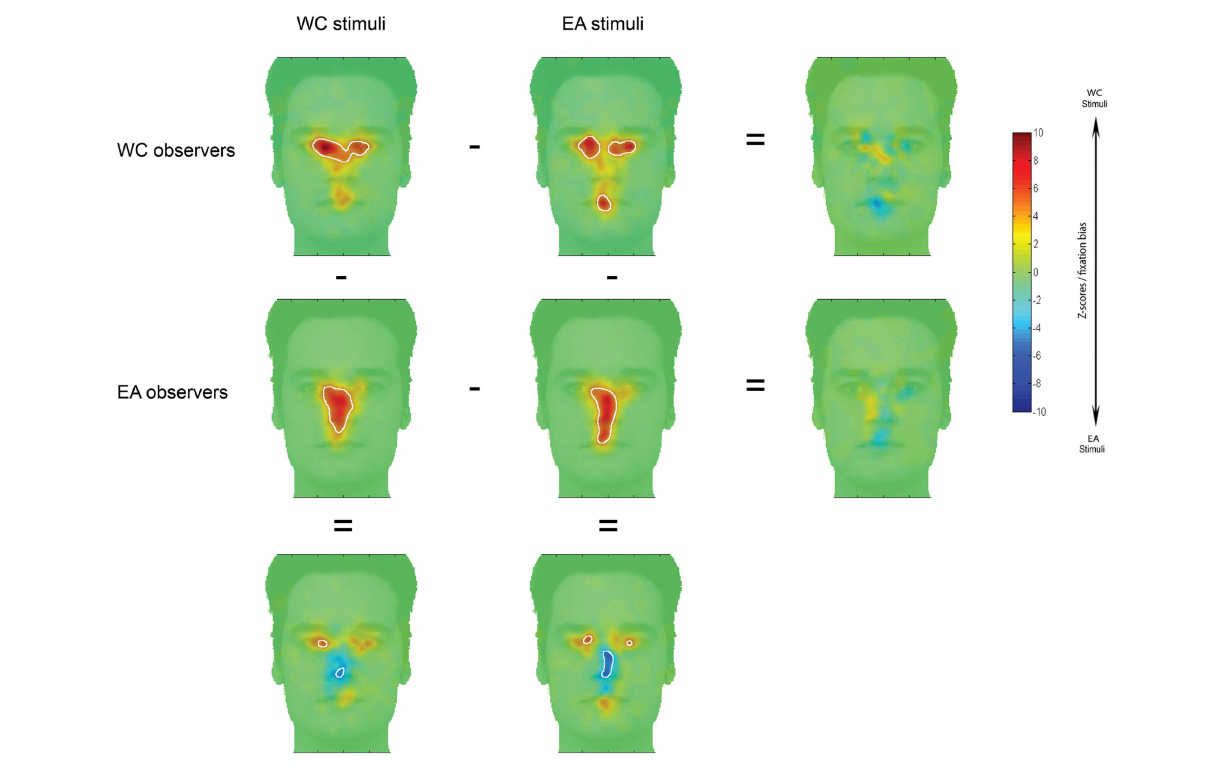
surround regions of significantly longer fixation durations than were observed for other areas; on the difference maps, white contours indicated regions of significant differences between the observers/stimuli maps (i.e., fixation